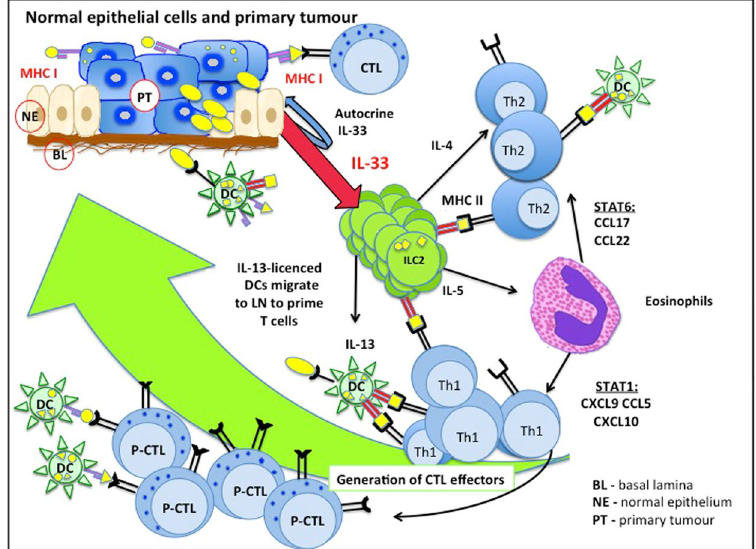
Figure 9. Model linking the adaptive and innate immune responses during tumour development via IL-33-ILC2 axis. IL-33-expressing tumour environment stimulates the development of ILC2 cells and functionally activates them through the ST2 receptor pathway. Functionally active ILC2s alter the tumour microenvironment triggering both innate and adaptive immune responses. ILC2s recruit DCs through IL-13 production, stimulate Th2 cells and possibly Th1 cells through direct ILC2 antigen presentation via MHC-II molecules, and indirectly stimulate CTL precursor cells through DC endogenous antigen presentation or cross-presentation via MHC-I molecules. Th1 and Th2 cells may also be activated by DCs through exogenous antigen presentation via MHC-II molecules. Through the release of IL-5 by ILC2s and subsequent recruitment of eosinophils, the chemokine profiles of tumour microenvironment is changed to attract Th1 and CD8 + T cells and to direct the activation of CTL-mediated killing and cancer rejection. This mechanism acts to suppress the frequency of circulating tumours cell and subsequent metastasis. In metastatic tumours with low IL-33 content, the IL-33/ILC2 pathway is not initiated and immune escape is